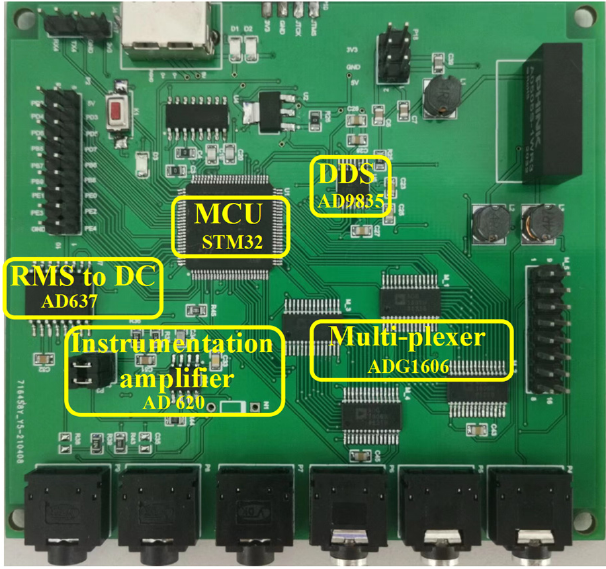
Figure 4. The data acquisition board.